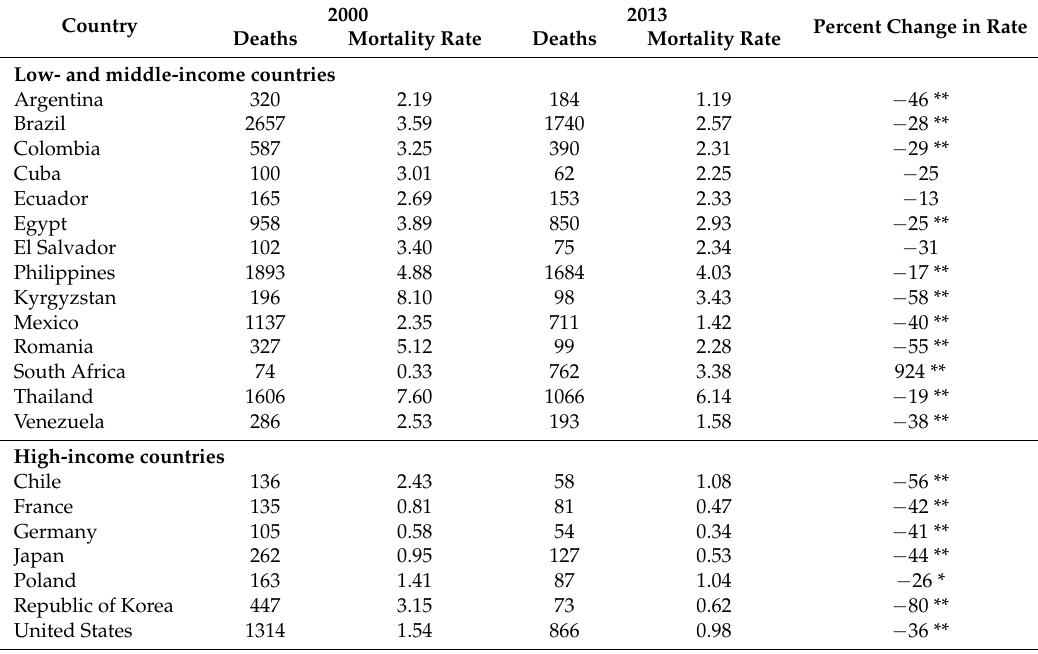
Table 1. Unintentional child and adolescent drowning deaths and age-adjusted mortality per 100,000 persons for 21 countries,